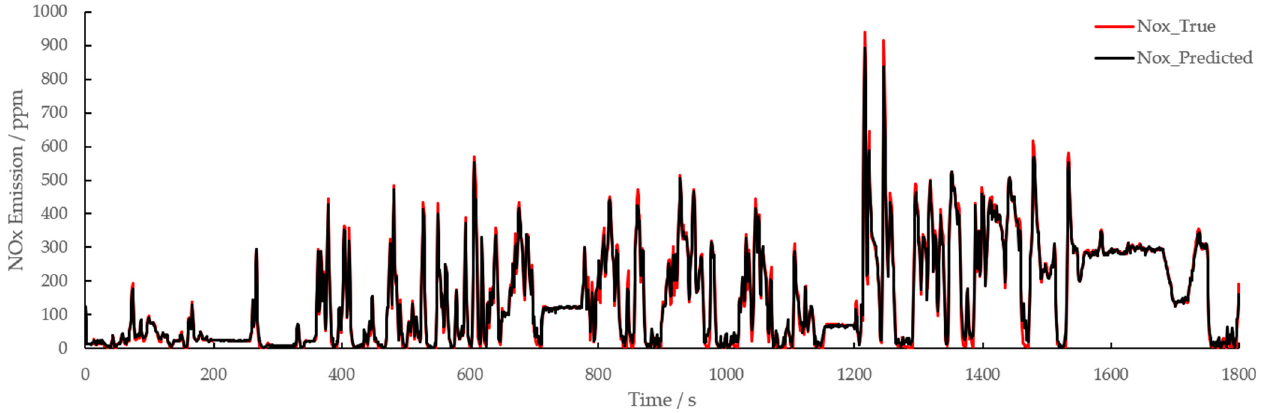
Figure 4. Engine torque prediction validation result under WHTC cycle condition.